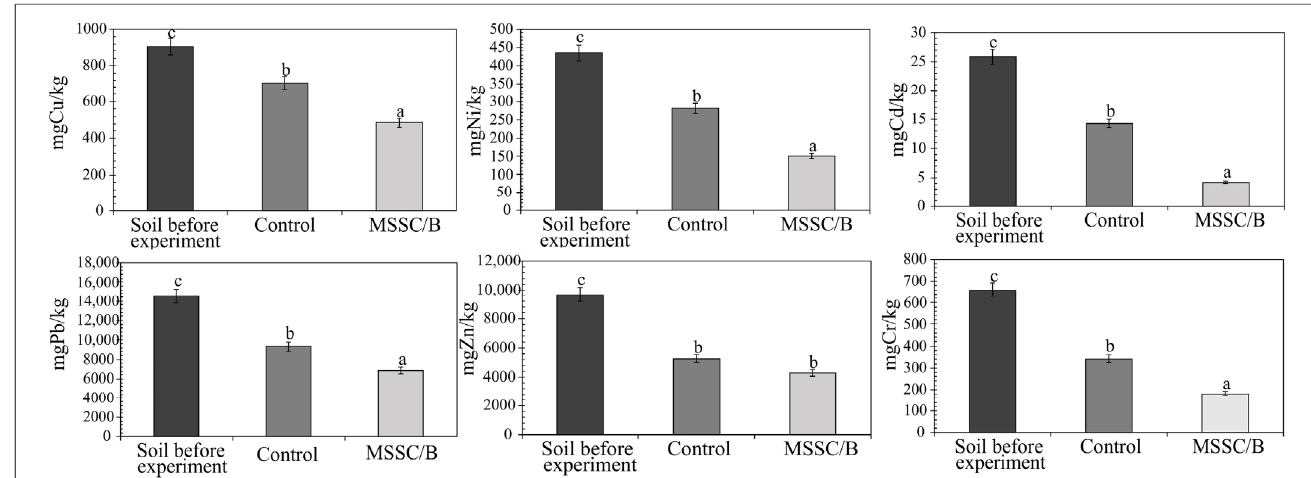
Figure 4. The Cu, Ni, Cd, Pb, Zn, and Cr contents in the soil after the application of MSSC/B. Mean ± SD with different lowercase letters indicate significant differences among treatments ( p < 0.05) using one-way ANOVA.